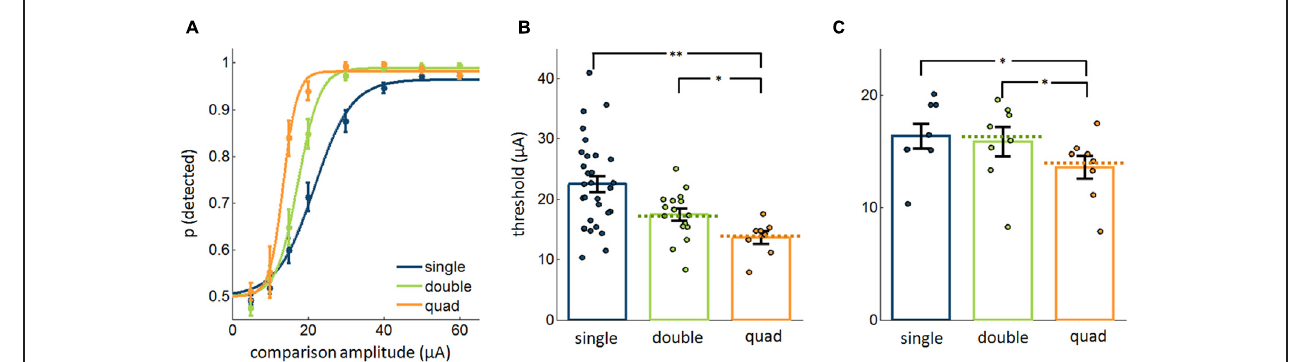
FIGURE 2 | Detectability of ICMS delivered through varying number of electrodes (20,577 trials from 54 electrodes). In these experiments, pulses occurred synchronously ( Figure 1B , left). (A) Psychometric functions, averaged across single electrodes, electrode pairs, and electrode quads. (B) Measured and theoretically calculated thresholds. The bars and error bars denote the mean and SEs, respectively, and each point corresponds to a different single